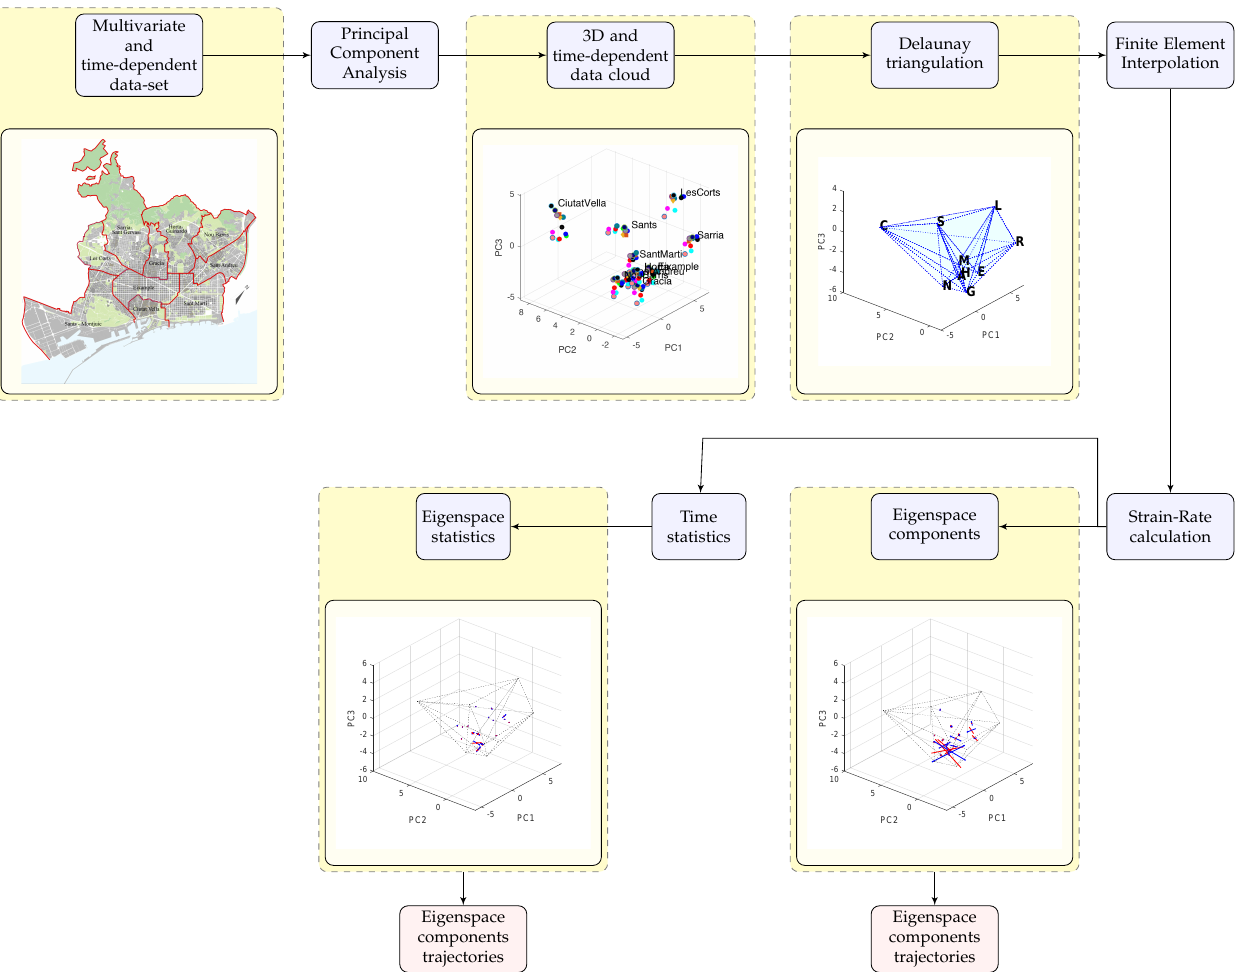
Figure 4. Flow chart of the temporal change visualization methodology.